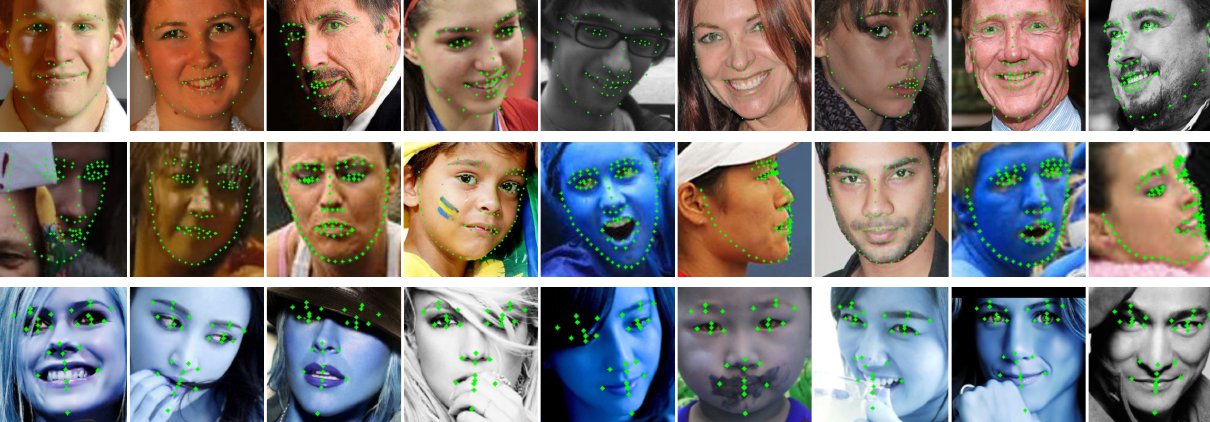
Figure 5. Example results of our method for face alignment. Top row: results on 300W (68 points). Second row: results on WFLW (98 points). Bottom row: results on COFW (29